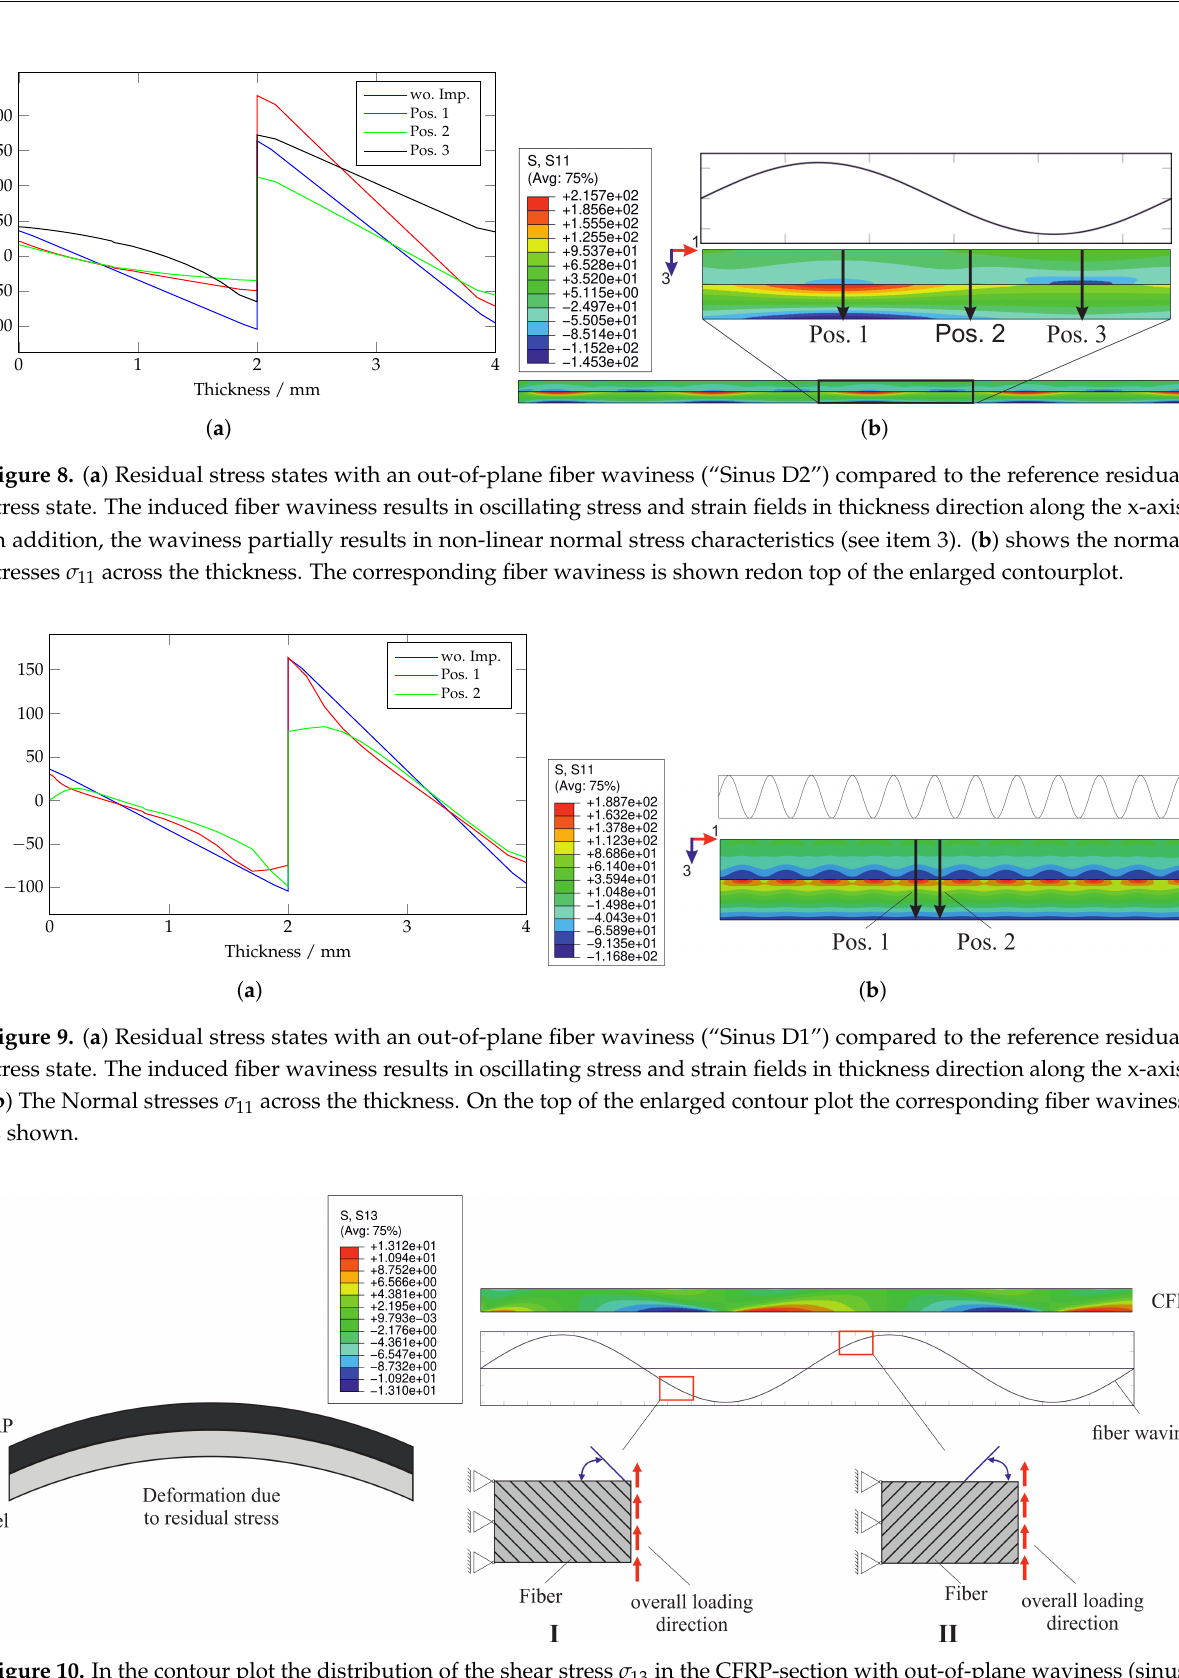
Figure 10. In the contour plot the distribution of the shear stress σ 13 in the CFRP-section with out-of-plane waviness (sinus D2) is illustrated. Below, the corresponding fiber waviness is plotted accordingly. Maximum shear stresses are located in areas with higher shear stiffness. The varying shear stiffness can be explained by the fact that the fiber orientation can oriented against (I) or with (II) the overall deformation